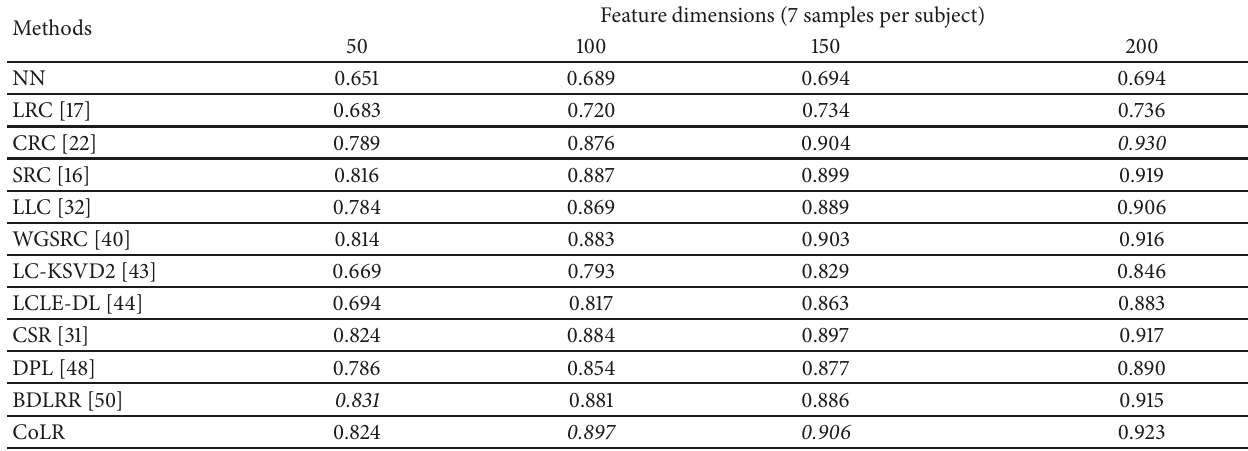
Table 9: Recognition rates on the AR dataset under different feature